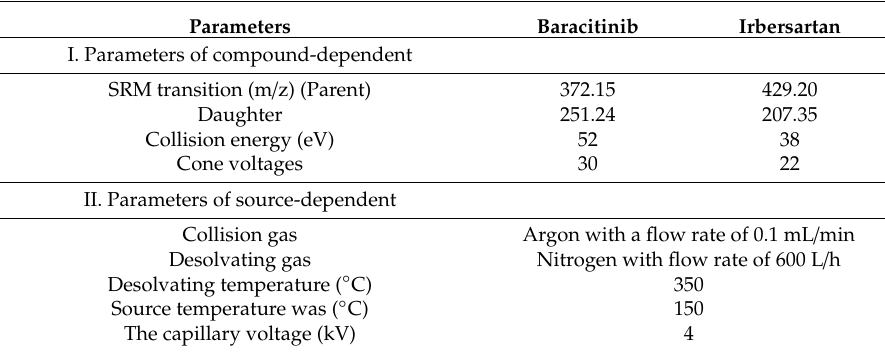
Table 5. Mass optimization parameter for, baracitinib and irbersartan